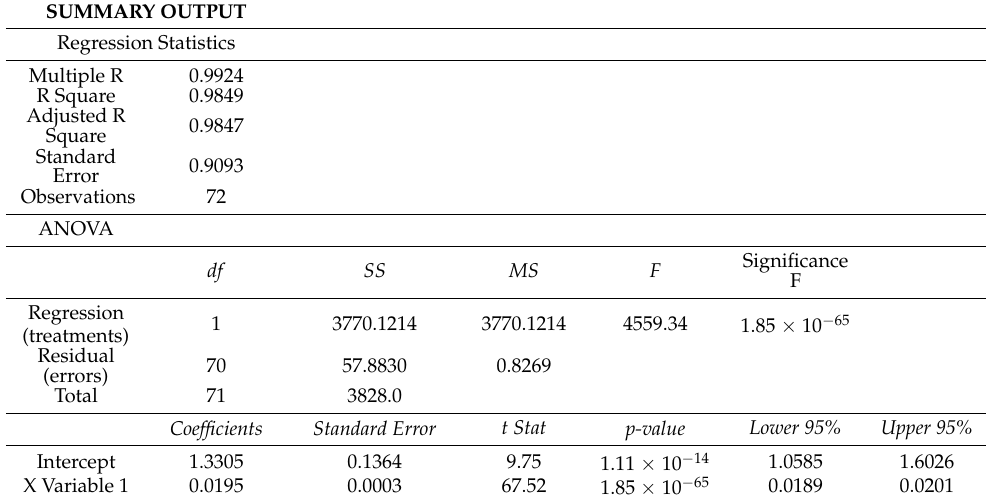
Table 7. Statistical data analysis for Re sine vs. Nu sine / Pr 1/3 ( µ / µ w ) 0.14